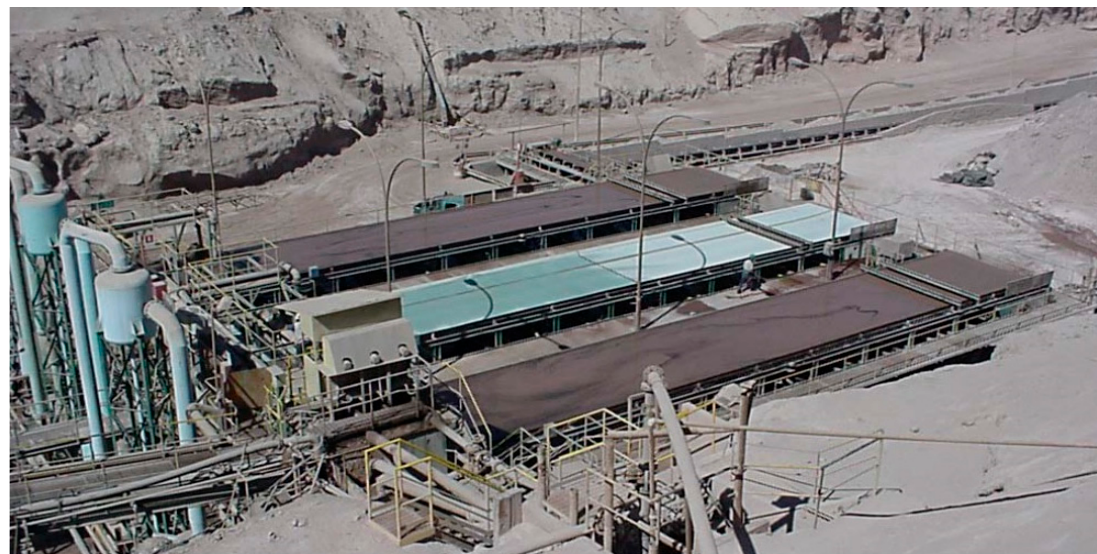
Figure 1. Tailings vacuum Belt Filters in Mantos Blancos Project [32].